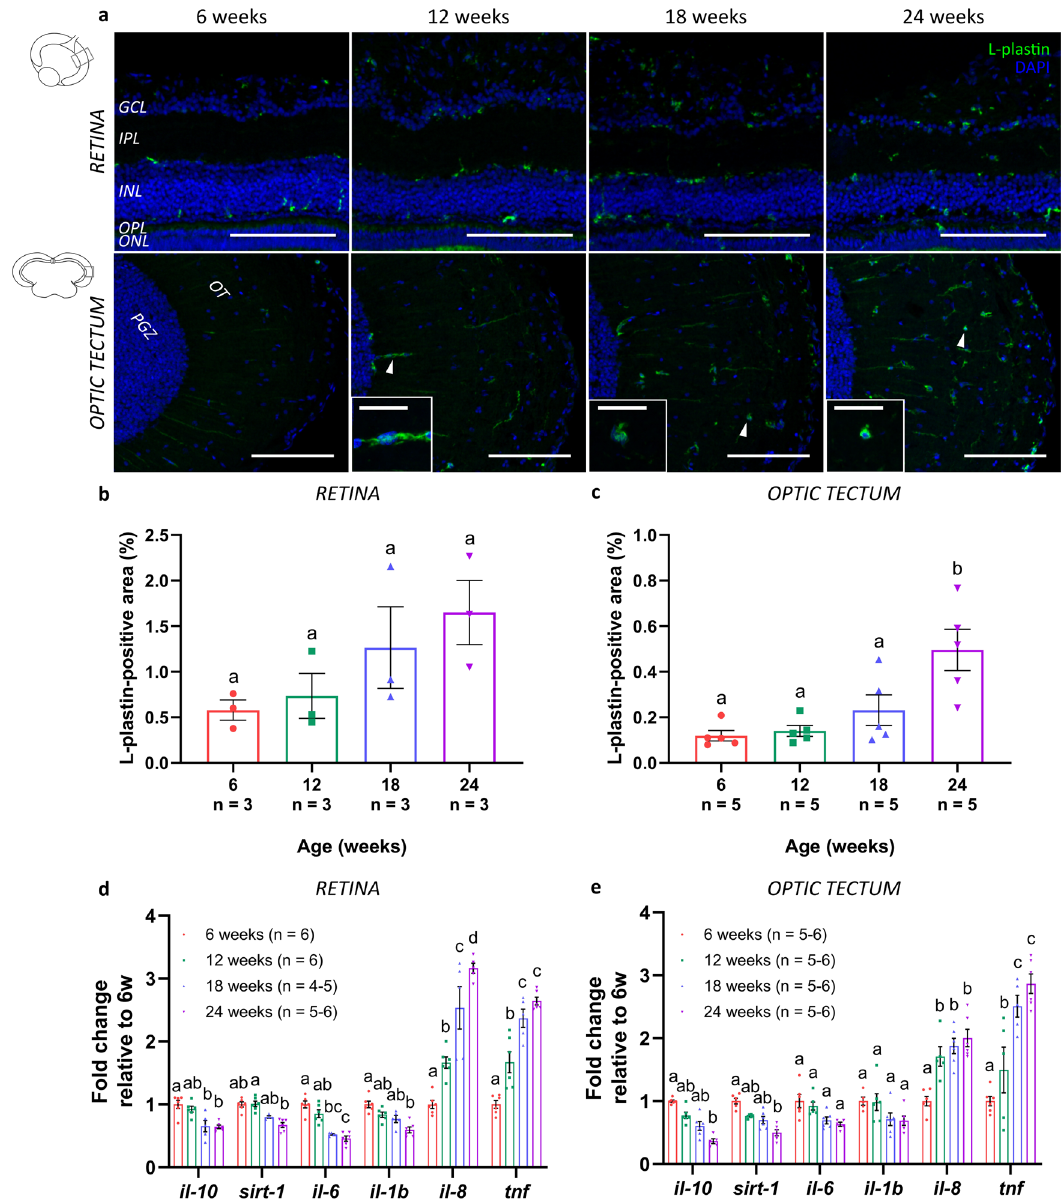
Fig. 6 In fl ammaging in the senescent killi fi sh visual system. a Representative images of the retina and the optic tectum immunolabeled for the pan-leukocyte marker L-plastin illustrate a visible increase in microglial/macrophage number with increasing age. Moreover, an age- dependent change in morphology is observed in 18-week- and 24-week-old fi sh, in which microglia seem to transform from a rami fi ed-like toward ameboid-like form (white arrowheads in optic tectum; magni fi ed in boxes; scale bar = 20 µm). Scale bar = 100 µm. b, c Quanti fi cation of the area occupied by immunostained leukocytes over the total analyzed area demonstrates an increase in the microglial/macrophage area fraction with increasing age. Values are shown as mean ± standard error of mean, n ≥ 3. d, e Quanti fi cation of mRNA levels of in fl ammatory molecules, such as il-10 , sirt-1 , il-6 , il-1b , sirt-1 , il-8 , and tnf , in both retinal and tectal lysates reveals signi fi cant changes in the expression pro fi le in the retina as well as optic tectum with advancing age. While the expression values of il-10 , sirt-1 , il-6 , and il-1b decline upon aging, levels of il- 8 and tnf increase in older fi sh. Values represent mean fold change values relative to values of 6-week-old fi sh ± standard error of mean, n ≥ 4. Statistical signi fi cance between different conditions is indicated using different letters. DAPI 4 ′ ,6-diamidino-2-phenylindole, GCL ganglion cell layer, NFL nerve fi ber layer, IPL inner plexiform layer, INL inner nuclear layer, OPL outer plexiform layer, ONL outer nuclear layer, PRL photoreceptor segment layer, SO stratum opticum , SFGS stratum fi brosum et griseum super fi ciale , SGC stratum griseum centrale , PGZ periventricular gray zone, OT optic tectum, il-10 interleukin 10 , il-1b interleukin 1 β , il-6 interleukin 6 , sirt-1 sirtuin 1 , il-8 interleukin 8 , tnf tumor necrosis factor BrdU-positive cells were clearly visible in all mitotic zones, independent of age, indicating that new cells were generated in